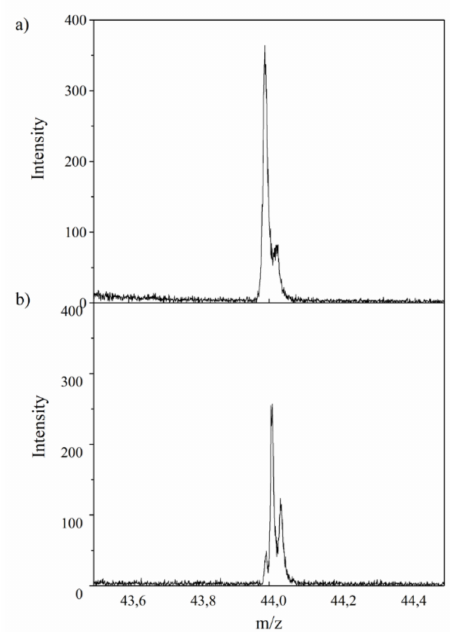
Figure 2. TOF-SIMS spectra of CO 2 − ions emitted from ( a ) AlMg − LH and ( b ) AlMg − LH/AD 10% samples.